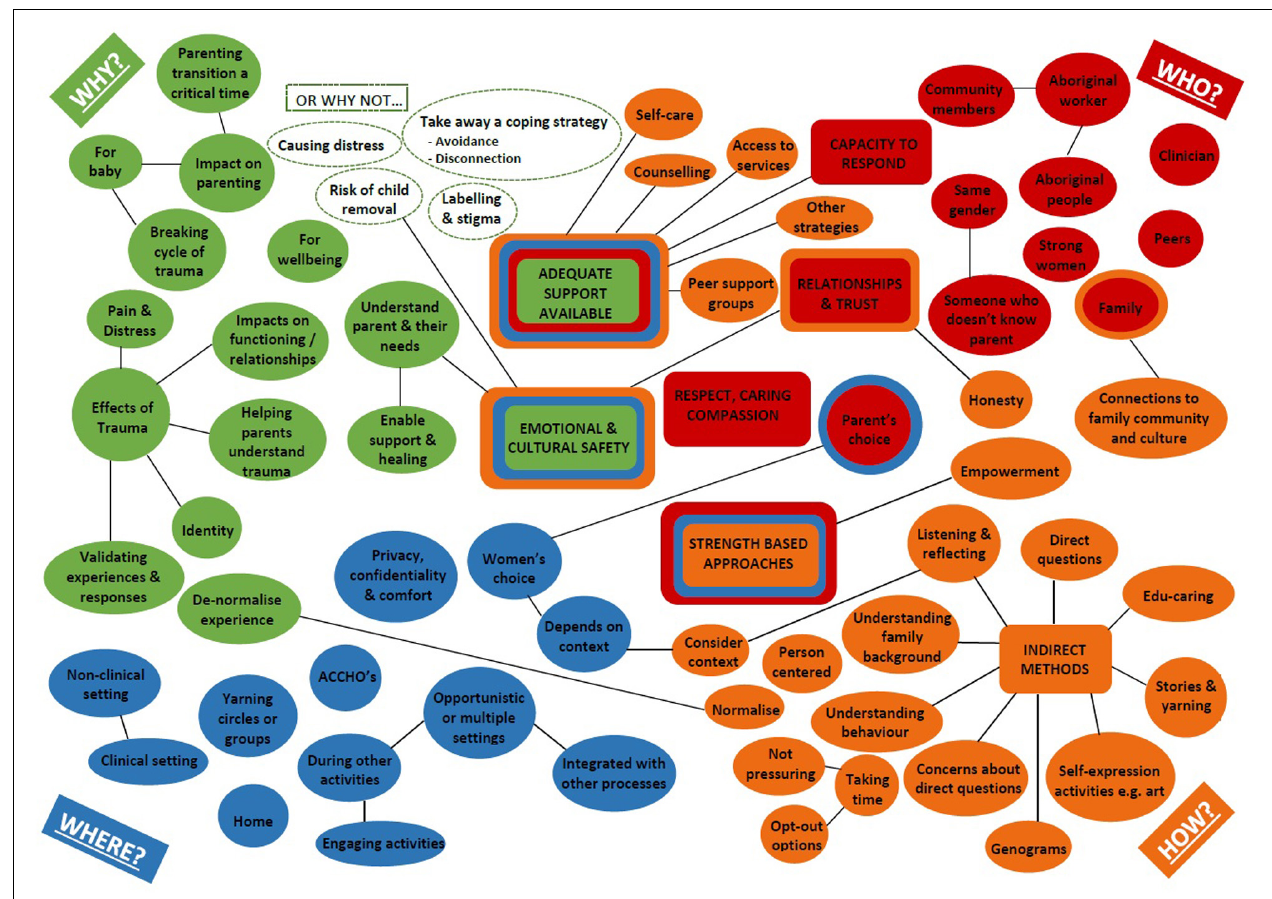
FIGURE 3 | Concept map illustrating key stakeholder perspectives regarding talking about complex trauma with Aboriginal